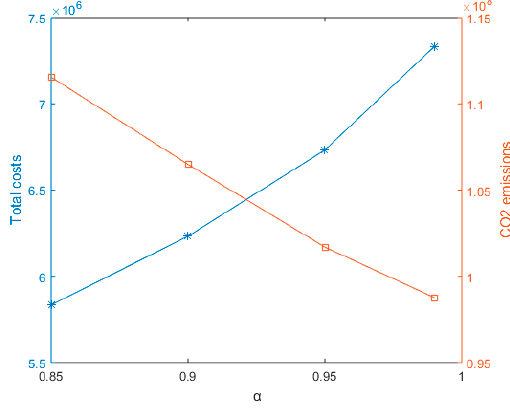
Figure 6. Sensitivity analysis of risk level to total costs and CO 2 emissions.